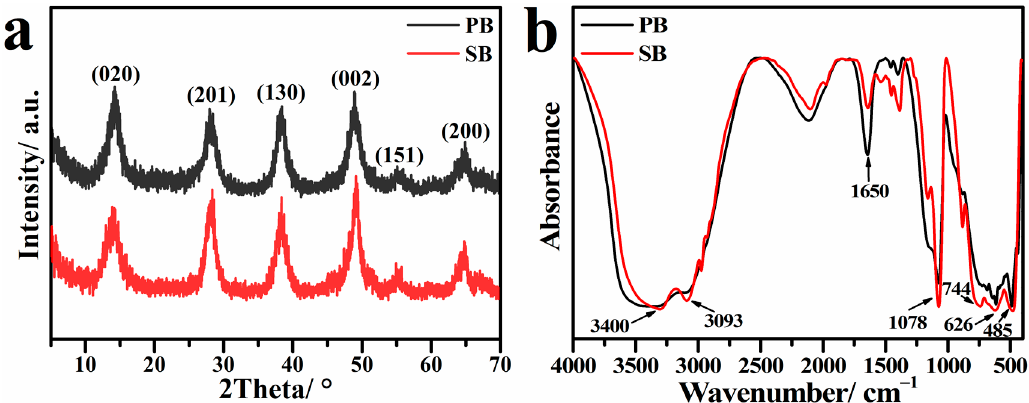
Figure 2. Powder XRD patterns ( a ) and FT − IR spectra ( b ) of PB and SB powder.